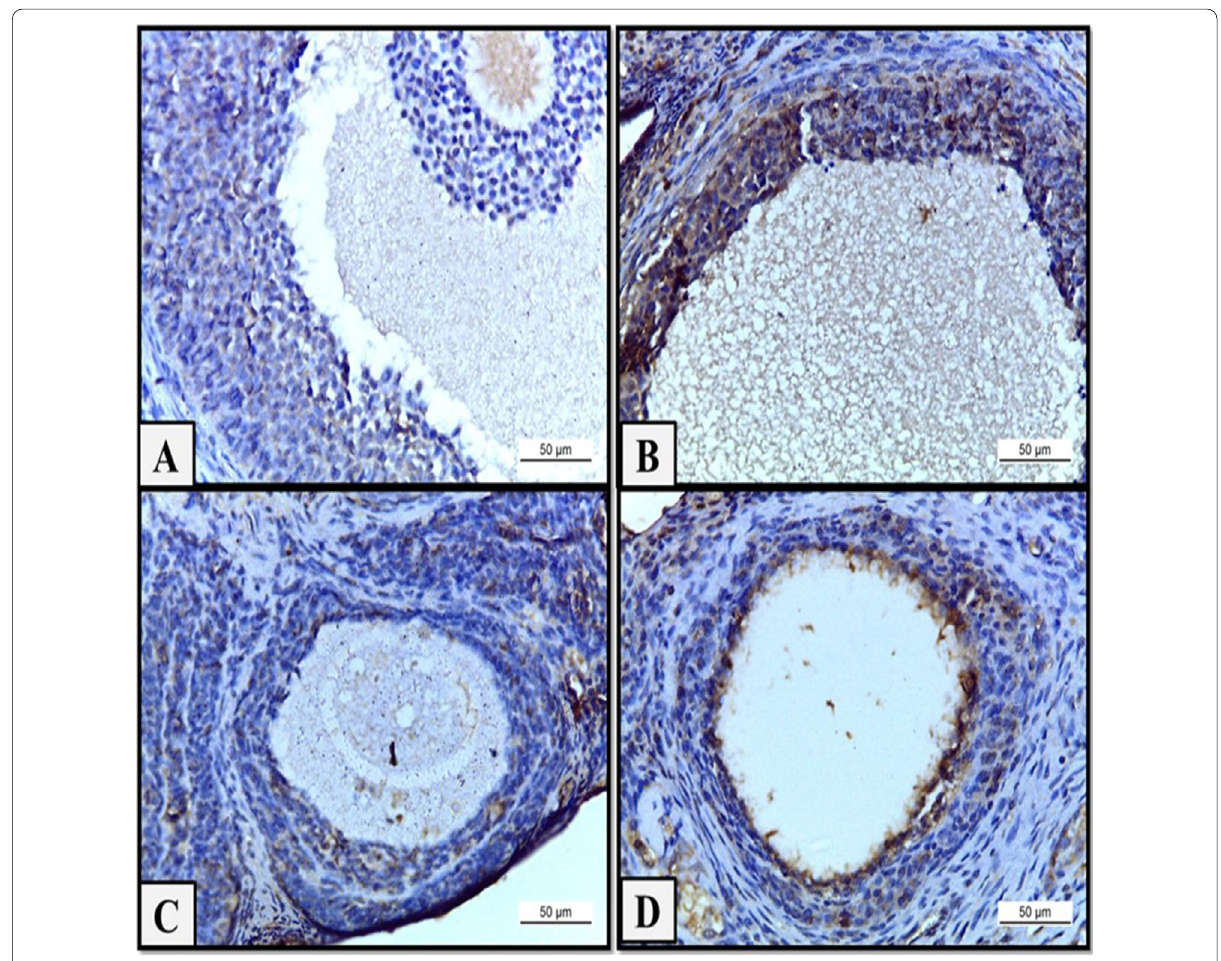
Fig. 5 A photomicrograph of caspase 3-stained sections (400 of caspase 3. B PCOS group showing intense positive immune reaction to caspase 3. C PCOS PCOS CLO showing moderate positive immune reaction to caspase 3. C: Control group, PCOS: letrozole induced polycystic ovarian syndrome, + PCOS LC: letrozole induced polycystic ovarian syndrome treated with l -Carnitine, PCOS + treated with Clomiphene